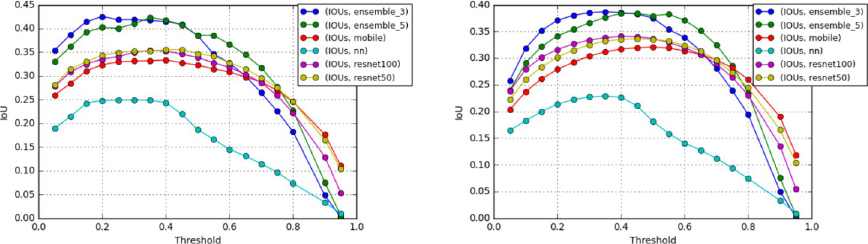
Fig 11. Average IoU of regions obtained from each model using different classification threshold values with postproceessing (left) and without it (right).